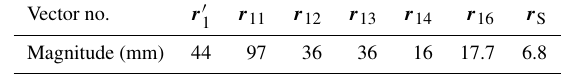
Table 3. Dimensions of the vectors. Vector no.